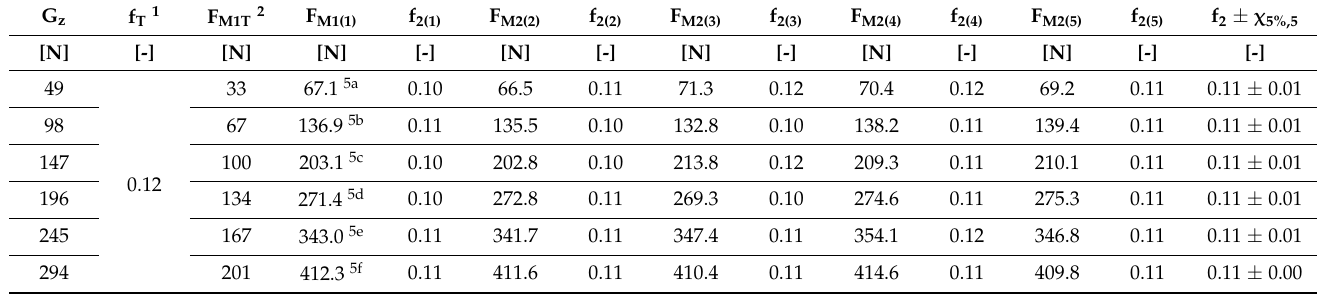
Table 5. Tensile force F M2(i) [N] , φ 6 mm rope, semi-circular groove, contaminated with oil.